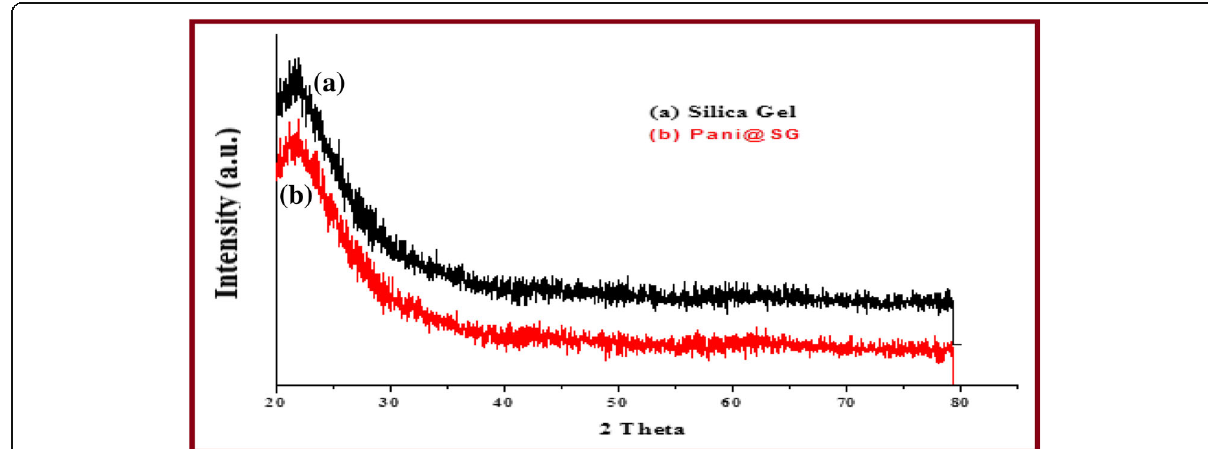
Fig. 2 XRD spectra of ( a ) silica gel (S 1 ) and ( b ) Pani@SG (ES)-S 2 nanocomposites